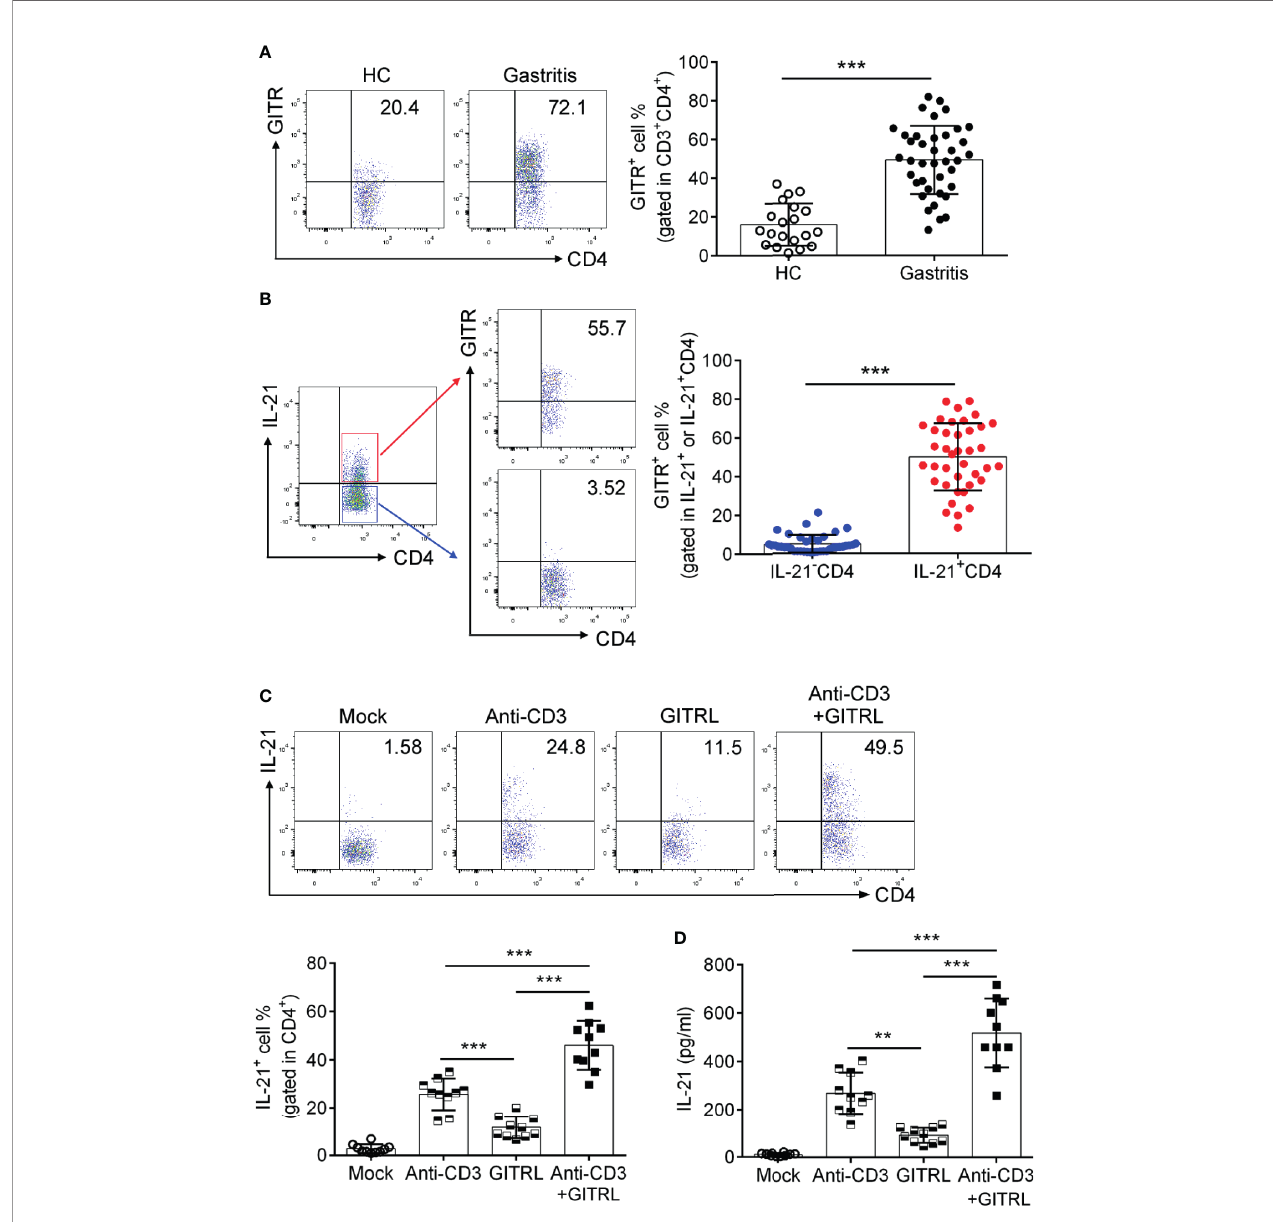
FIGURE 2 | Glucocorticoid-induced tumor necrosis factor receptor (GITR) promoted the polarization of 21 + TFH-like cells in Helicobacter pylori -positive gastritis. Biopsy samples of gastric mucosa from H. pylori -positive patients ( n = 39) and healthy controls ( n = 20) were collected. The GITR expression in (A) CD4 + T cells and (B) IL-21 + or IL-21 - CD4 + T cells was determined by fl ow cytometry. (C) The sorted gastric CD4 + T cells were stimulated with CD3 agonist Ab or recombinant GITRL protein. At 3 days later, IL-21 production by CD4 + T cells was determined by fl ow cytometry. (D) CD4 + T cells were isolated from the gastric mucosa of H. pylori - positive patients and treated with CD3 agonist Ab or recombinant GITRL protein. At 3 days later, the IL-21 concentration in the culture supernatant was determined by ELISA. Unpaired Student ’ s t -test was performed to determine the difference between the two groups. One-way ANOVA was used to compare among three or multiple groups. Data are displayed as mean ± SD from at least three independent experiments. ** P < 0.01; *** P <